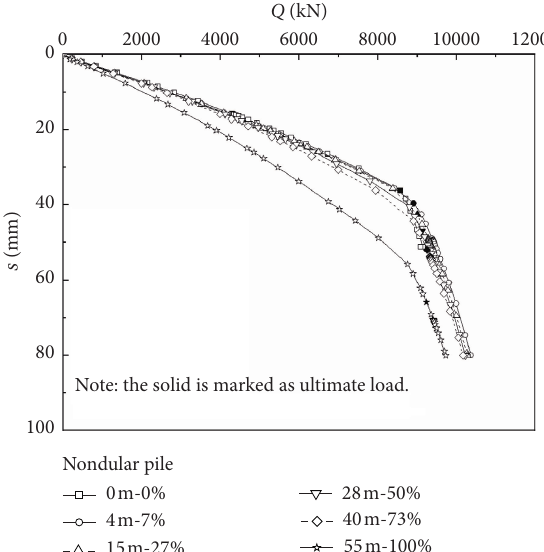
Figure 13: Influence of the proportion of the nodular pile on bearing capacity.